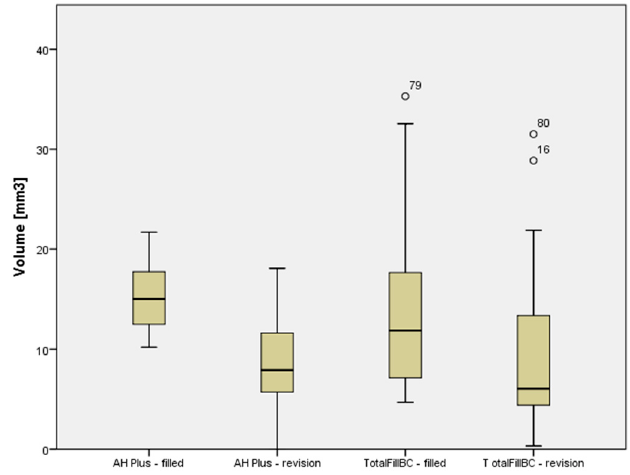
Figure 2. Plots of the scores given to the volumes of sealers in two groups before and after retreatment.